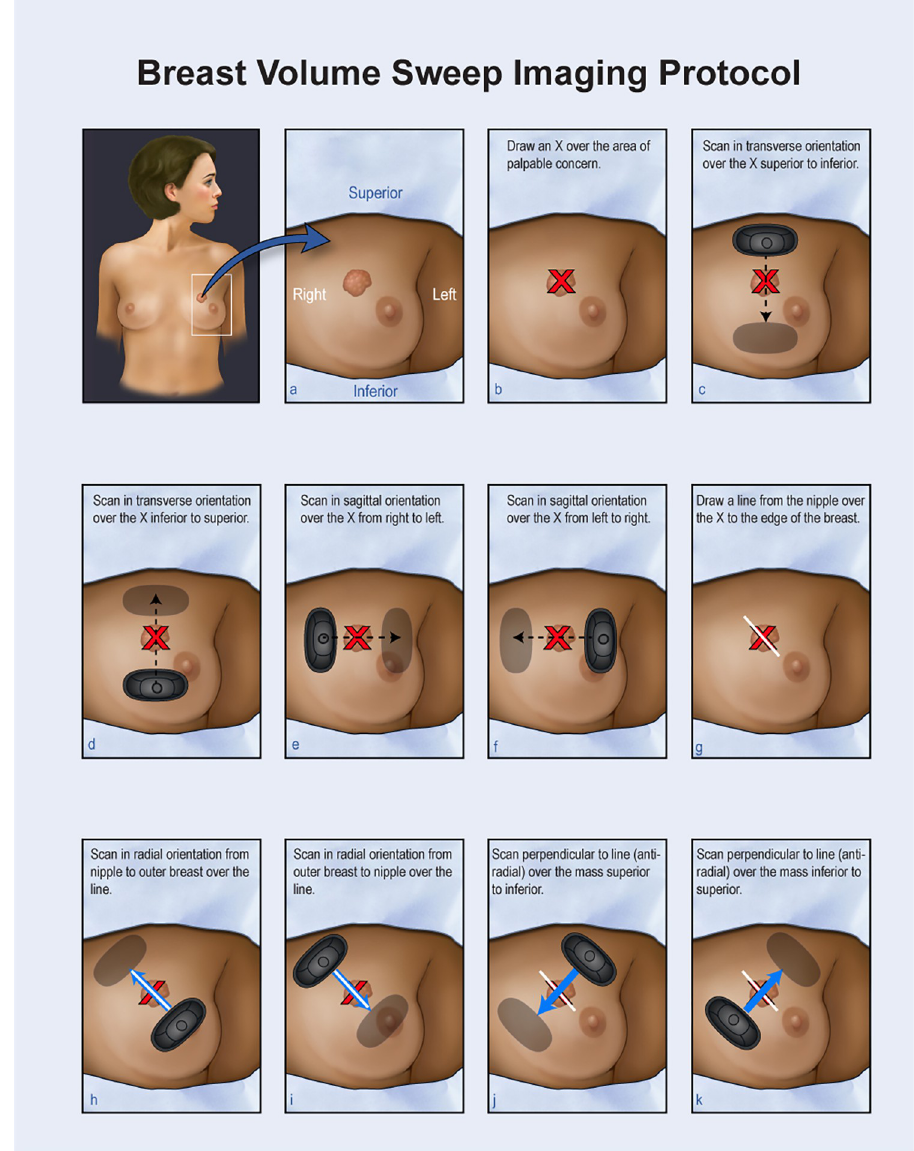
Fig 5. Breast VSI Poster. Illustration of how to perform breast VSI. Sweeps of the ultrasound probe are performed in the transverse, sagittal, radial, and anti-radial